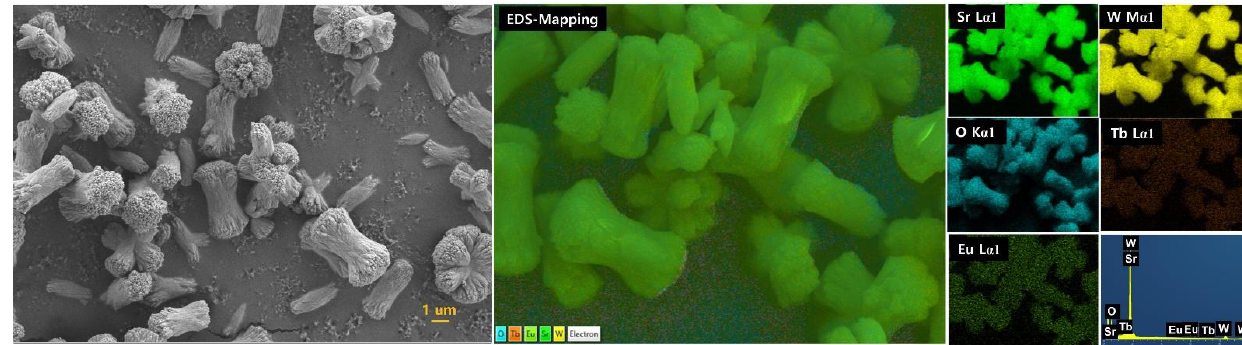
Figure 5. ( a ) XRD patterns of SrWO 4 :[Eu 3+ ]/[Tb 3+ ] and ( b ) change of d (112) spacing. Figure 6 shows the FE-SEM images and energy dispersive X-ray spectroscopy (EDS)